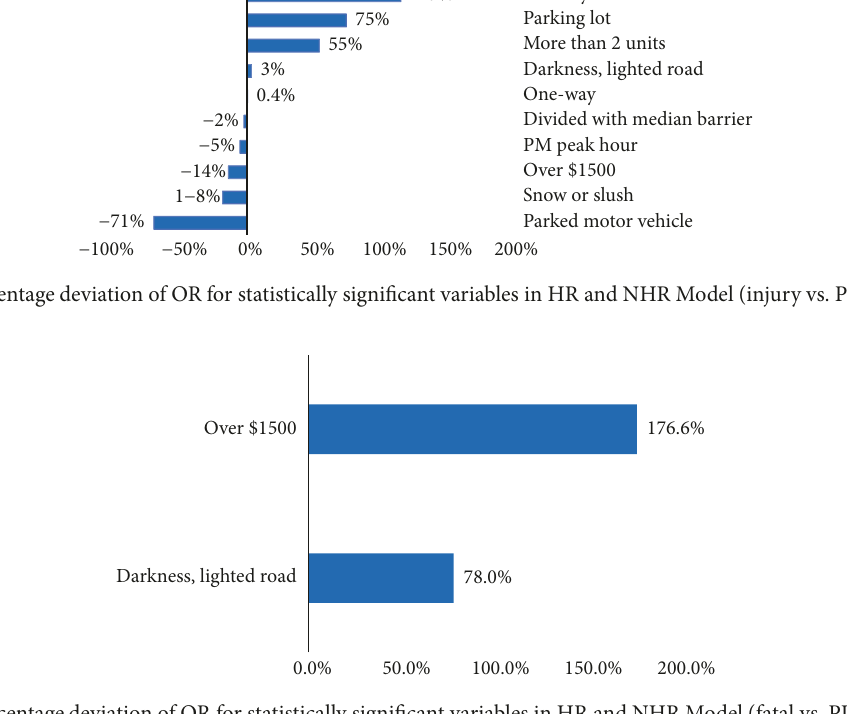
emergency medical service after the offending driver